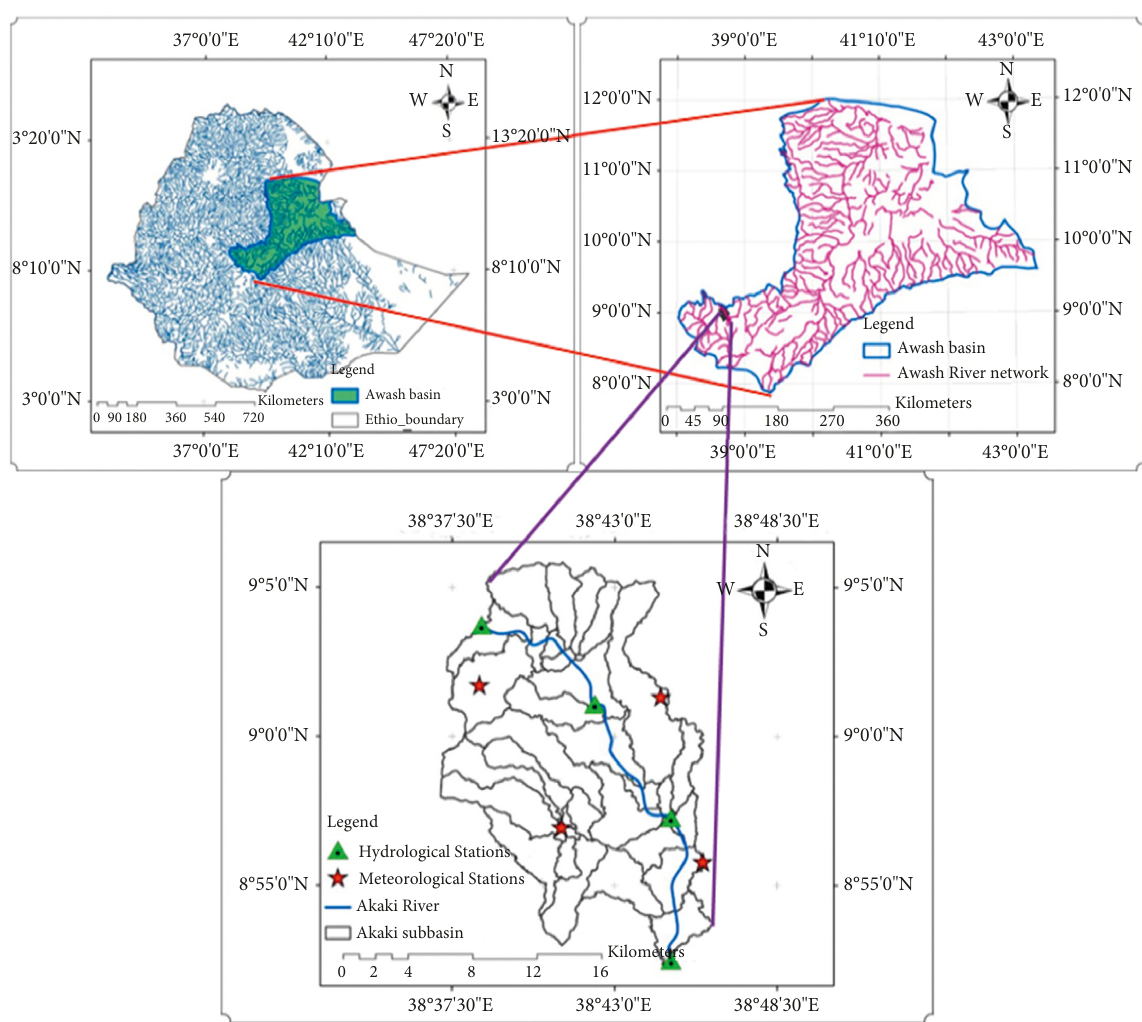
Figure 1: Map of the study area.